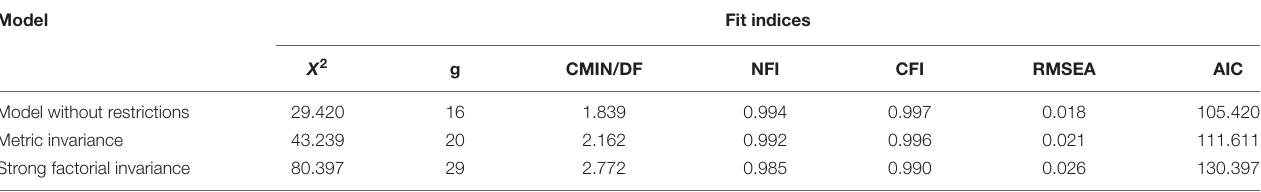
TABLE 6 | Goodness of fit indices for each of the models tested for factorial invariance (* p < 0.05). Model